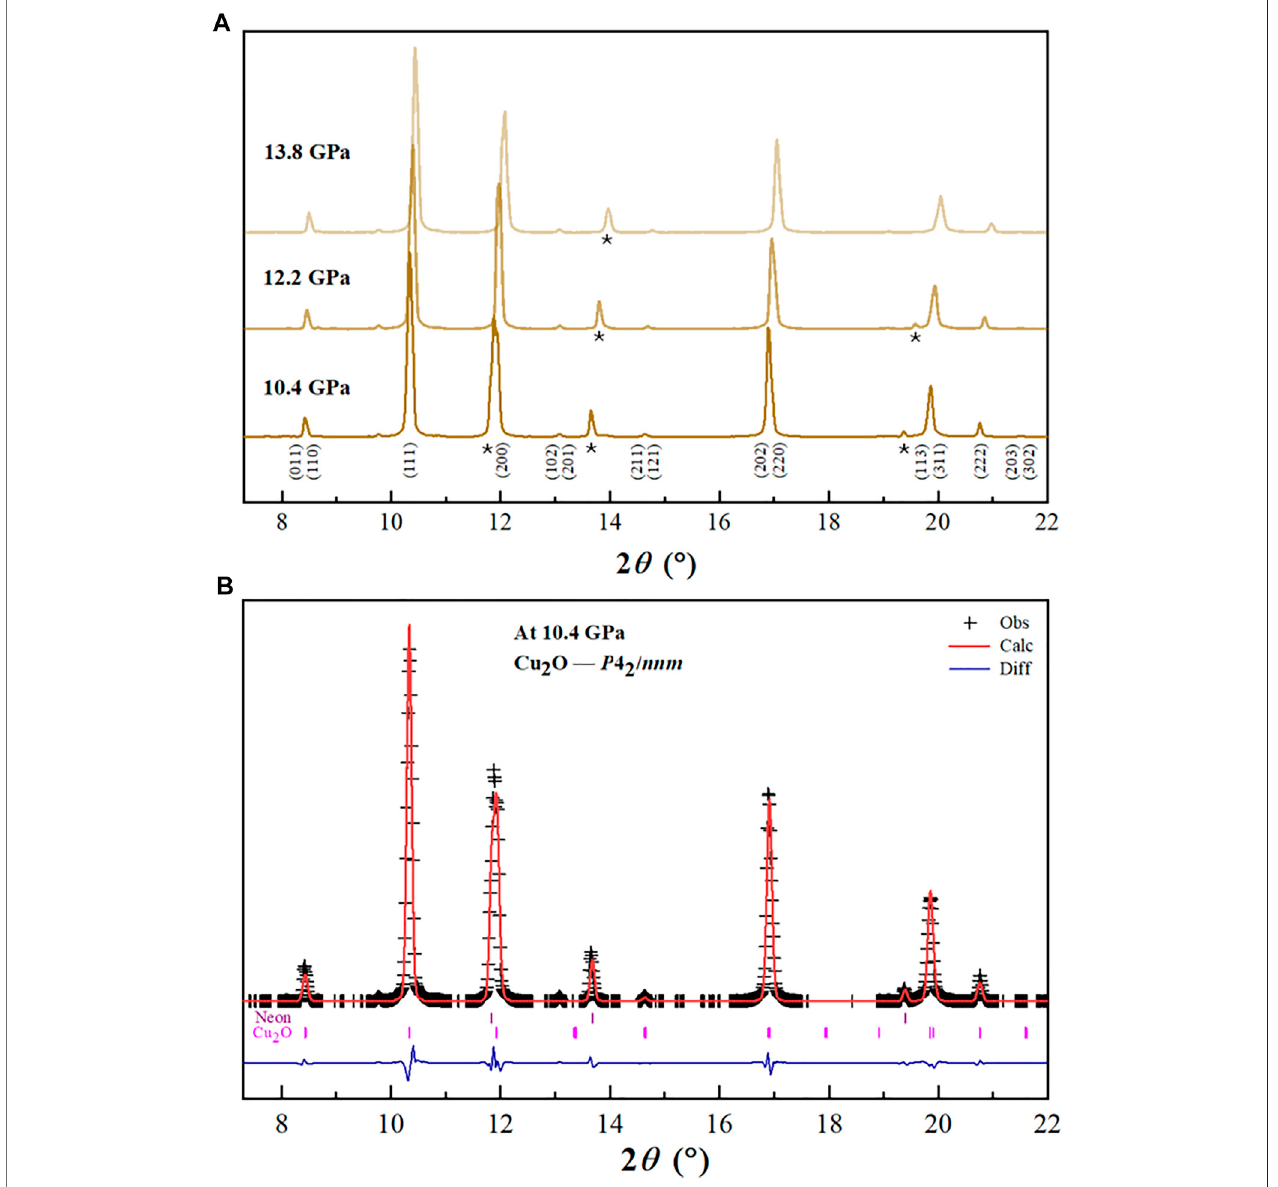
FIGURE 2 | (A) Selected XRD patterns of Cu 2 O in the tetragonal phase. Asterisk (*) represents the scattering peaks of neon. (B) The Rietveld re fi nement of Cu 2 O ( P 4 2 / nnm ). Observed and the calculated pro fi les are shown using black crosses and red solid line, respectively. The residual between them is shown by the blue line at the bottom. Bragg peak positions are indicated by the small